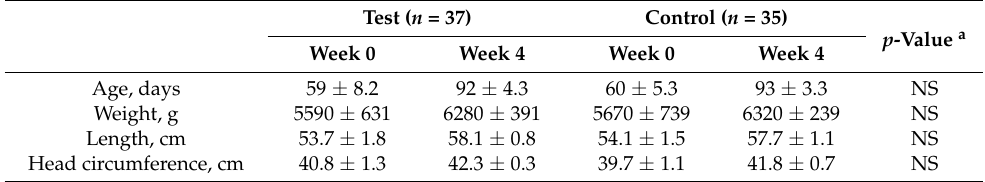
Table 2. Age and anthropometric measures (mean ± standard deviation) at baseline (week 0) and at the end of the study (week 4) in the test and control groups.